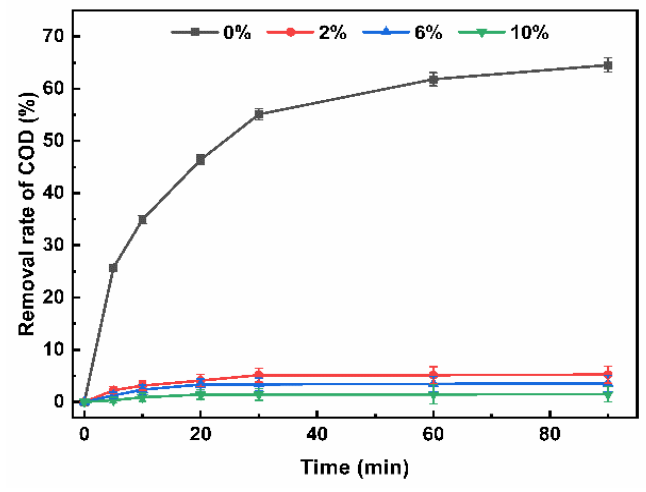
Figure 8. Effect of HO • scavenger on the degradation of organic matter in acrylic acid wastewater.